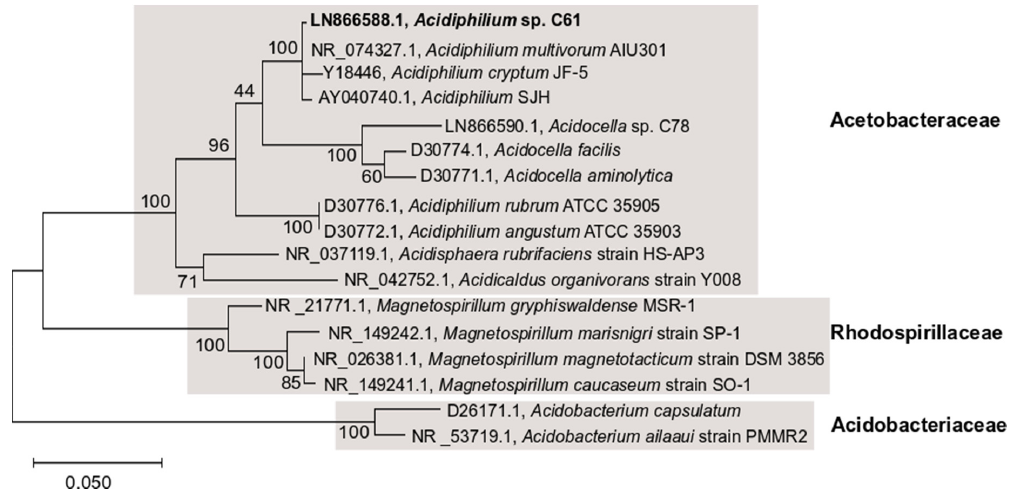
Figure 1. 16S rRNA gene phylogenetic tree of Acidiphilium sp. C61 (bold) with other closely related isolates. The tree was reconstructed using the maximum likelihood method. GeneBank accession numbers for sequences are given. Scale bar shows 0.05 change per nucleotide position.